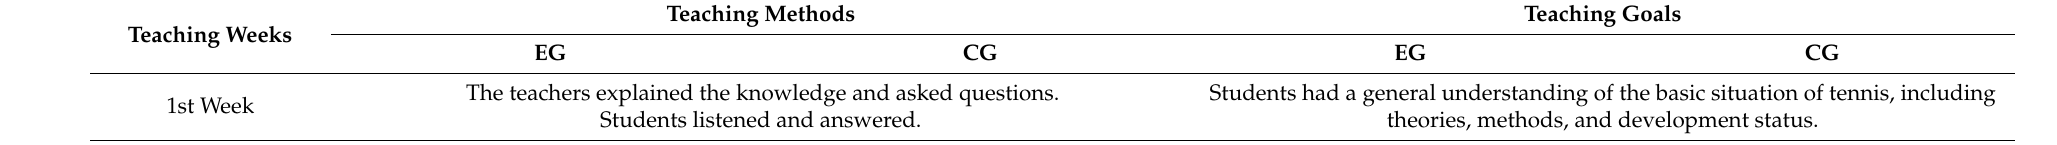
Table 3. Comparison of Teaching Methods and Goals between EG and